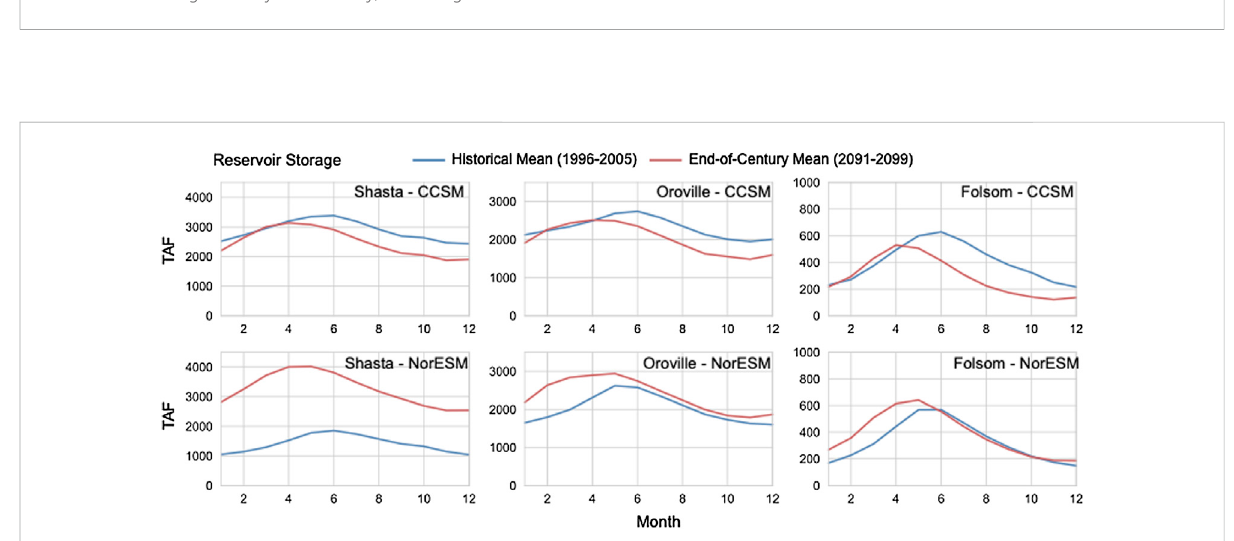
FIGURE 12 (A – L) Differencesindecade-averageddailystream fl owbetweenhistoricalandend-centuryWRFsimulations.Positivevaluesindicateincreases in stream fl ow magnitude by end century, while negative values indicate decreases.